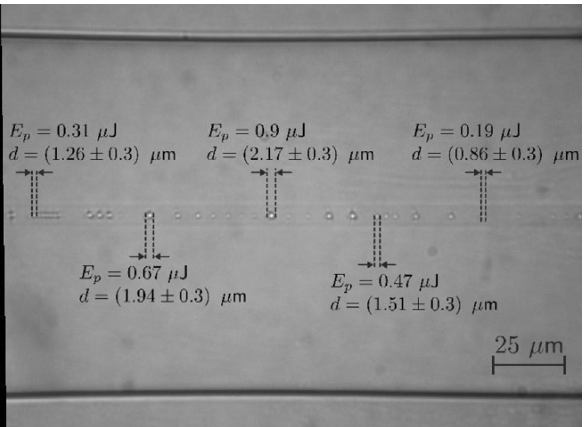
Figure 1. Microscope image of the quasi-randomly distributed reflector along the